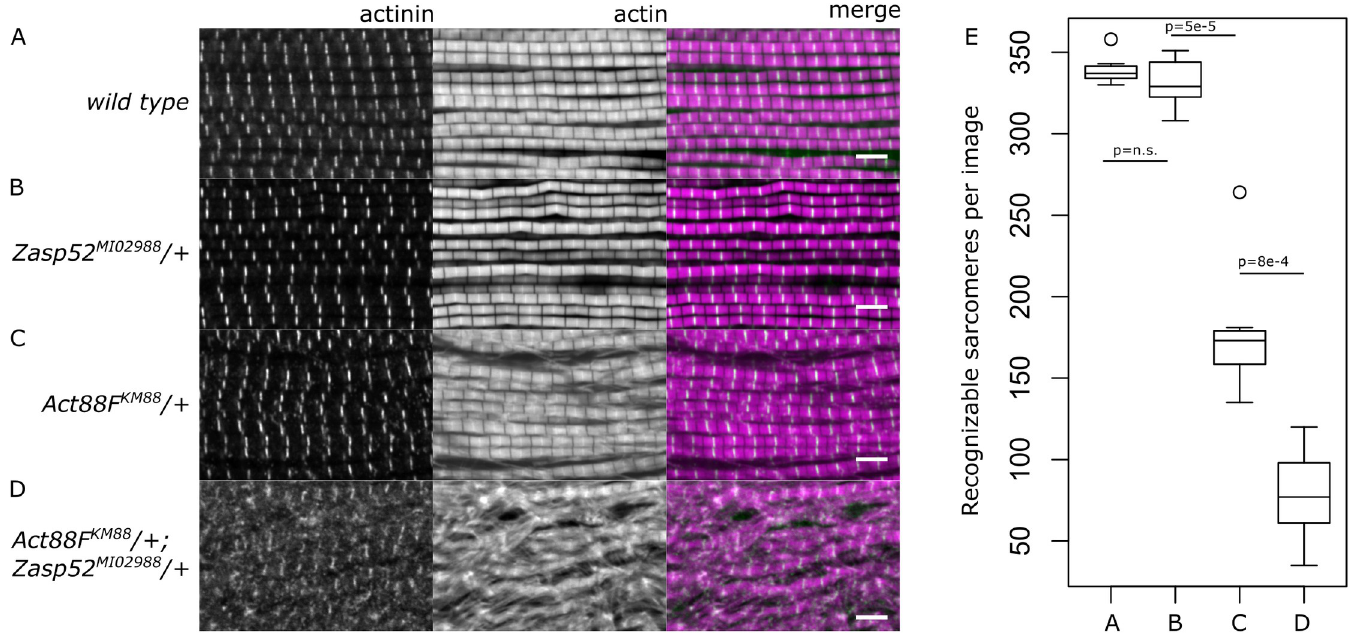
Fig 1. Zasp52 MI02988 and Act88F KM88 interact genetically during myofibril assembly. Confocal microscopy images of IFM of wild type flies and heterozygotes stained with phalloidin (magenta) to visualize myofibrils, and anti- α -actinin antibody (green) to visualize Z-discs. ( A ) Wild type myofibrils show no defects with properly formed sarcomeres. ( B ) Zasp52 MI02988 /+ heterozygotes look indistinguishable from wild type. ( C ) In the Act88 KM88 /+ heterozygote, myofibrils form properly, but some frayed myofibrils and loss of sarcomere structure occurs compared to wild type flies. ( D ) The Zasp52 MI02988 /+; Act88F KM88 /+ transheterozygotes frequently exhibit frayed myofibrils and fragmented Z-discs, and sometimes complete loss of sarcomere integrity. ( E ) Box plot of quantification of remaining sarcomeres per image in wild type flies, and various transheterozygous mutants. n = 7 muscle fibers. Scale bar, 5 μ m. P-values were calculated using Welch’s two-sample t-test followed by Bonferroni correction.